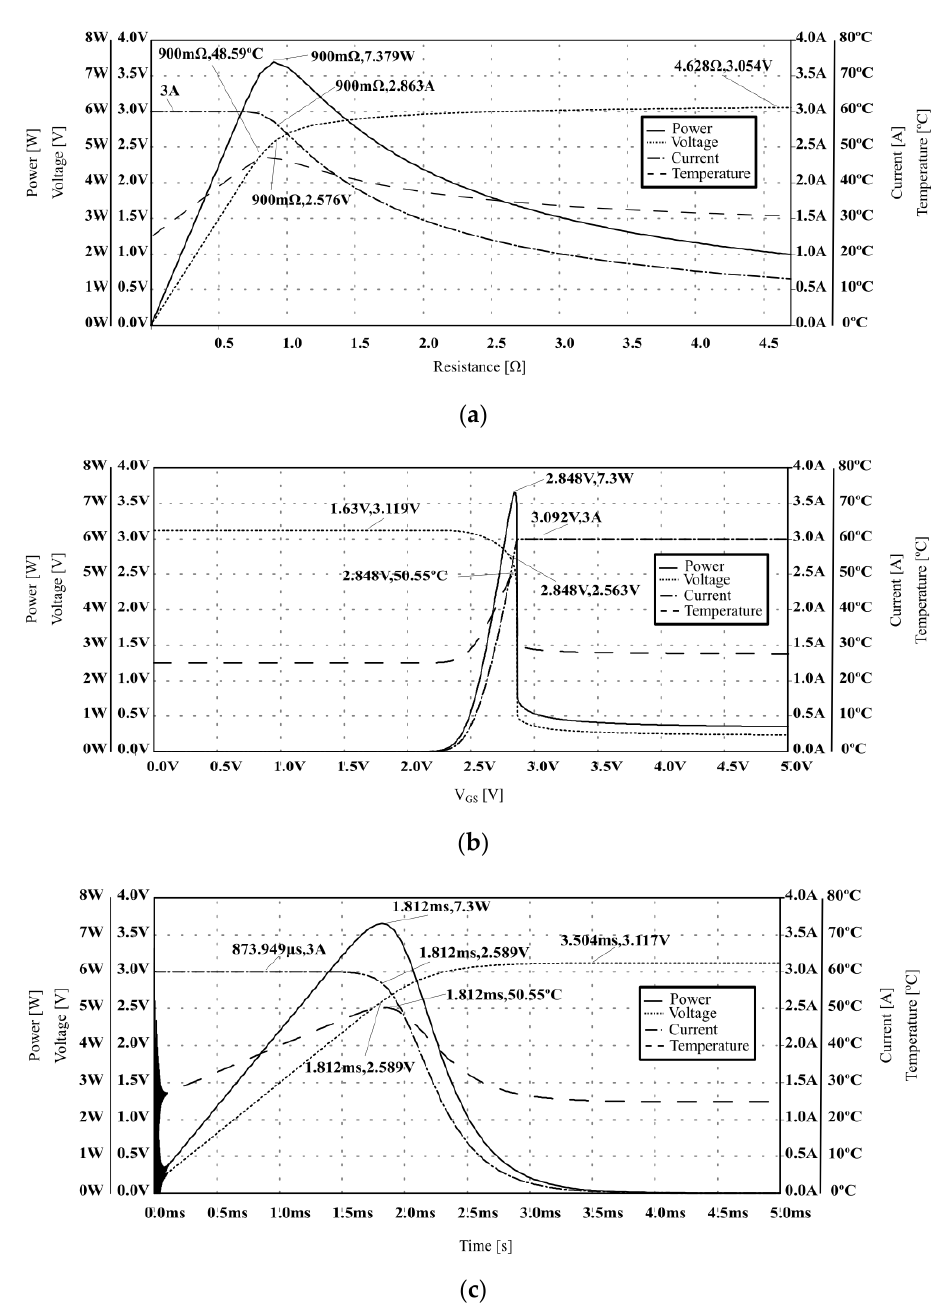
Figure 19. Electrical parameters in elements of a tracer: ( a ) variable resistance tracer; ( b ) MOSFET in electronic load tracer; ( c ) capacitive load tracer.